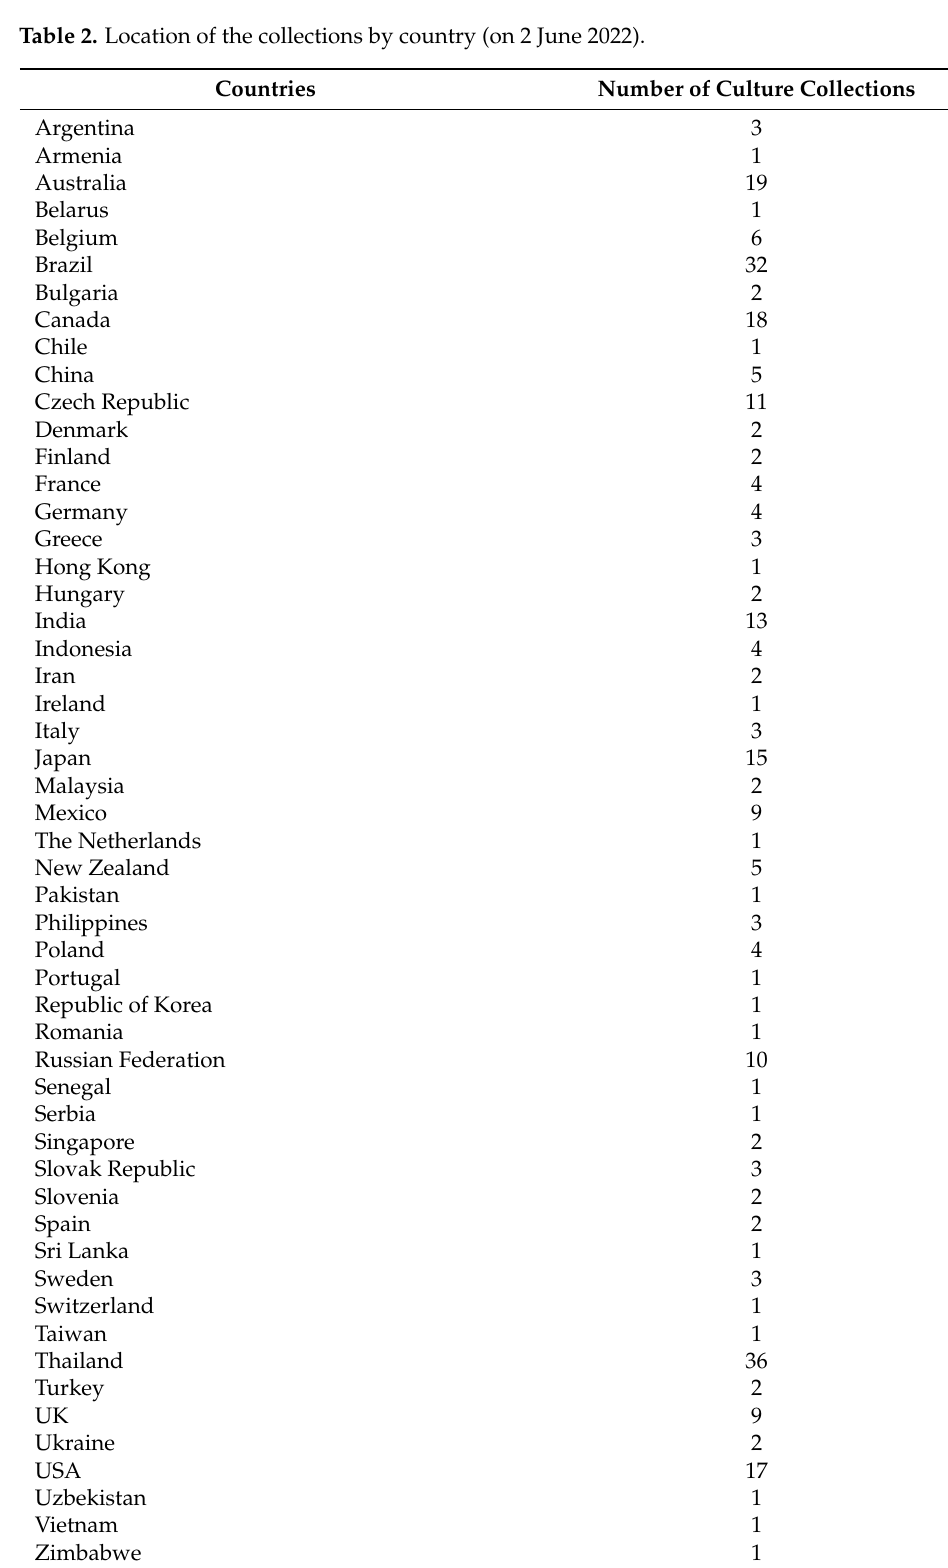
Table 2. Location of the collections by country (on 2 June 2022).